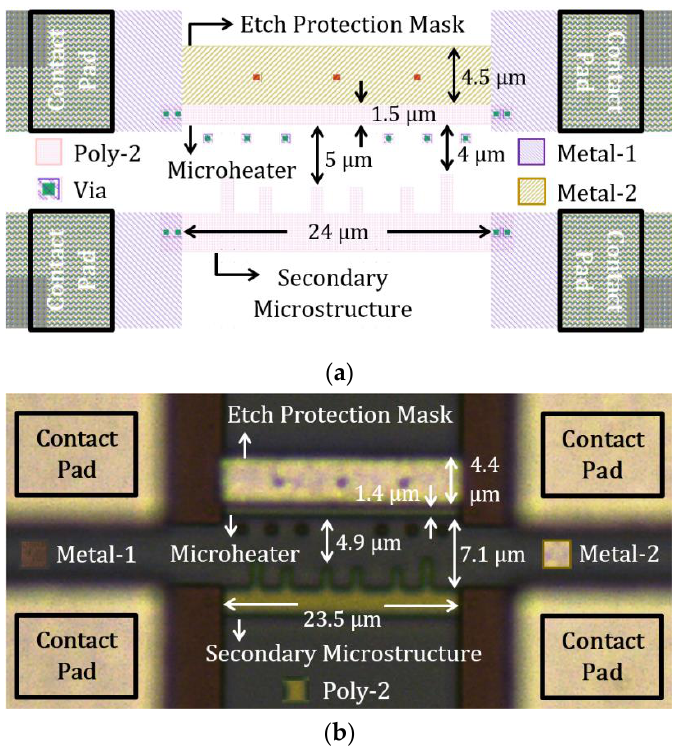
Figure 12. Poly-2 CNT growth structures in AMS 350 nm process: ( a ) layout design and ( b ) optical micrograph.